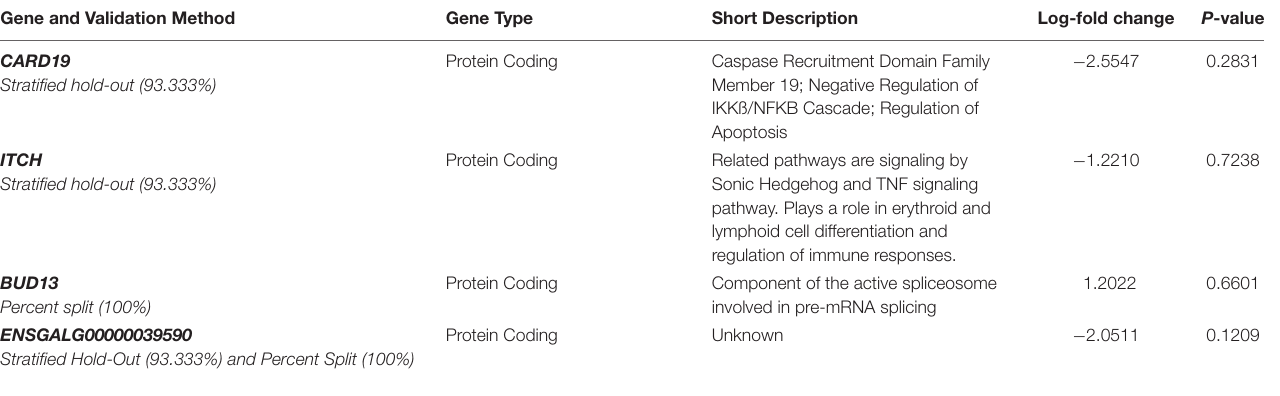
TABLE 3 | Top regulators of differential expressed genes in the liver of birds with normal PM compared to severe/moderate WB tissues using